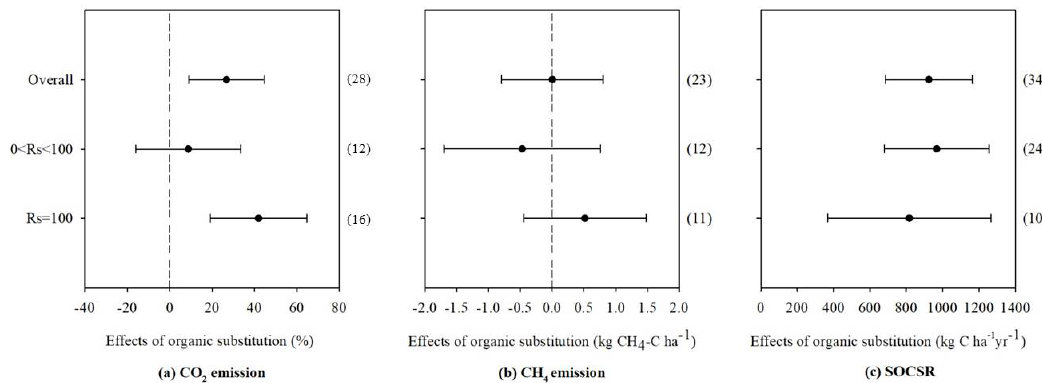
Figure 7. Effects of organic fertilizer substitution on CO 2 emissions ( a ), CH 4 emissions ( b ), and the soil organic carbon sequestration rate (SOCSR) ( c ) for maize production under four substitution rates. Rs, substitution rate, defined as organic nitrogen (N) input/total N applied (%). Error bars represent 95% confidence intervals. Numbers in parentheses indicate the numbers of observations.